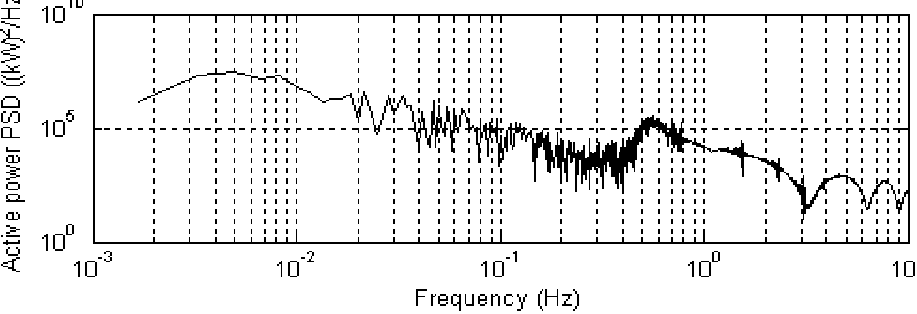
with mean wind speed between st